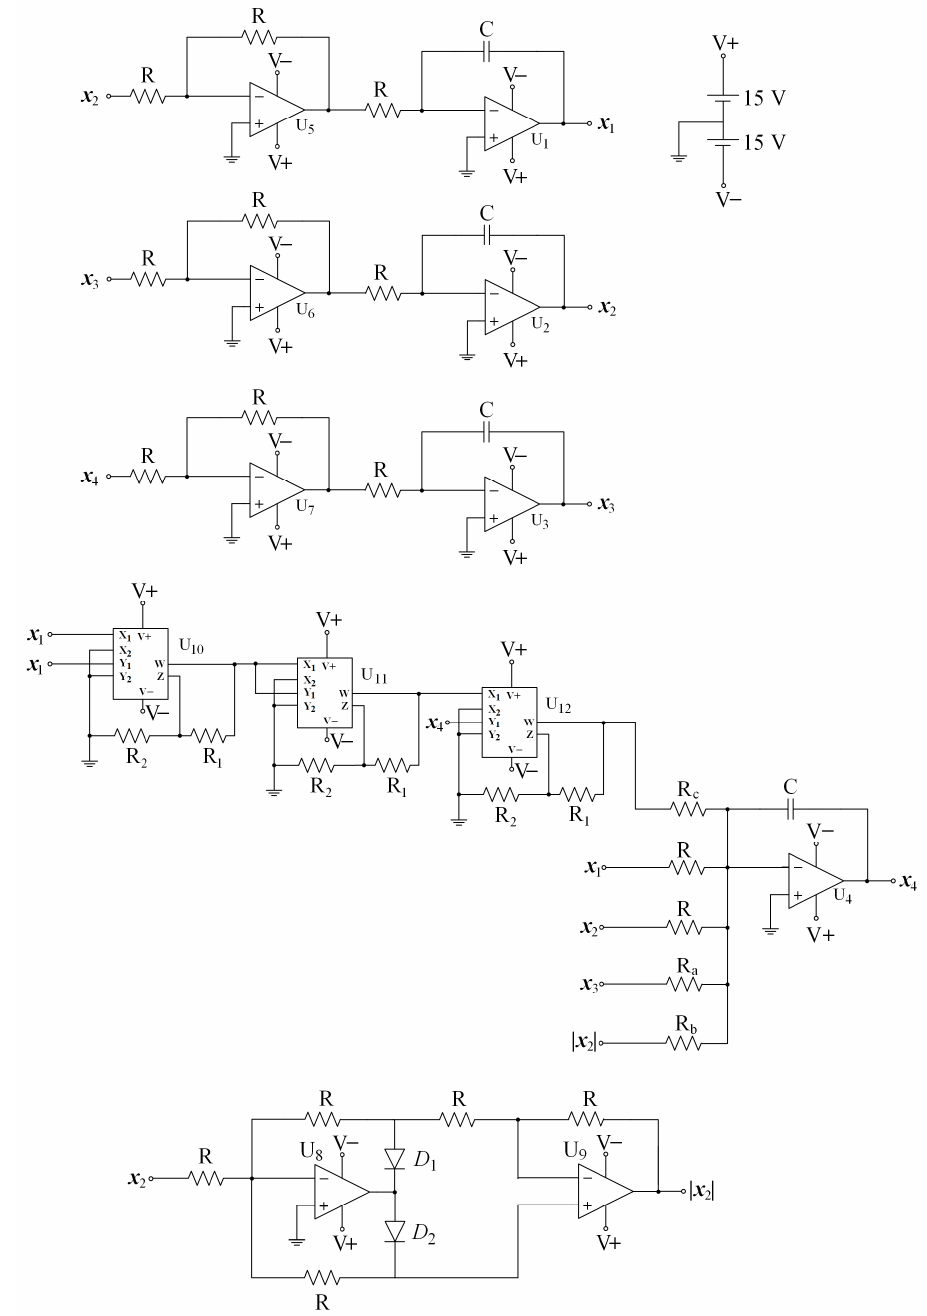
Figure 6. Schematic of the designed circuit for the proposed system (8).